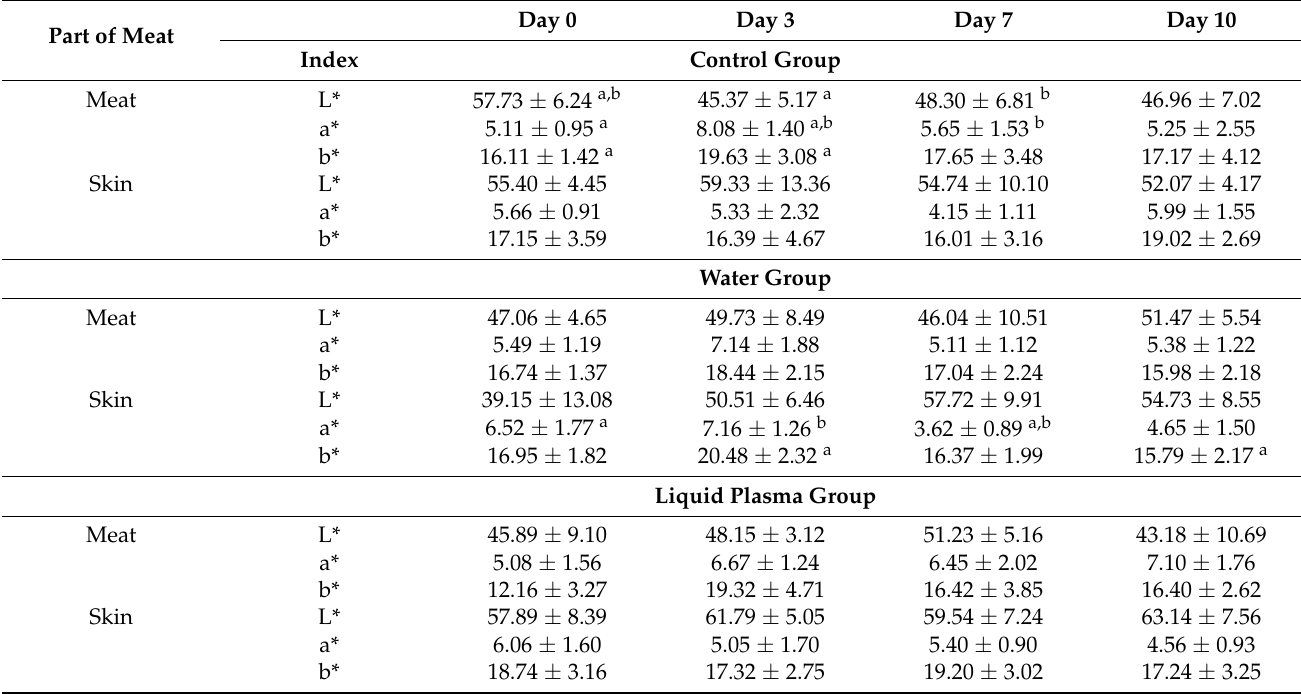
Table 10. Means of color values based on lightness (L*), the red–green index (a*), and the yellow– blue index (b*) on the surface of chicken meat samples in the control, water immersion, and liquid plasma